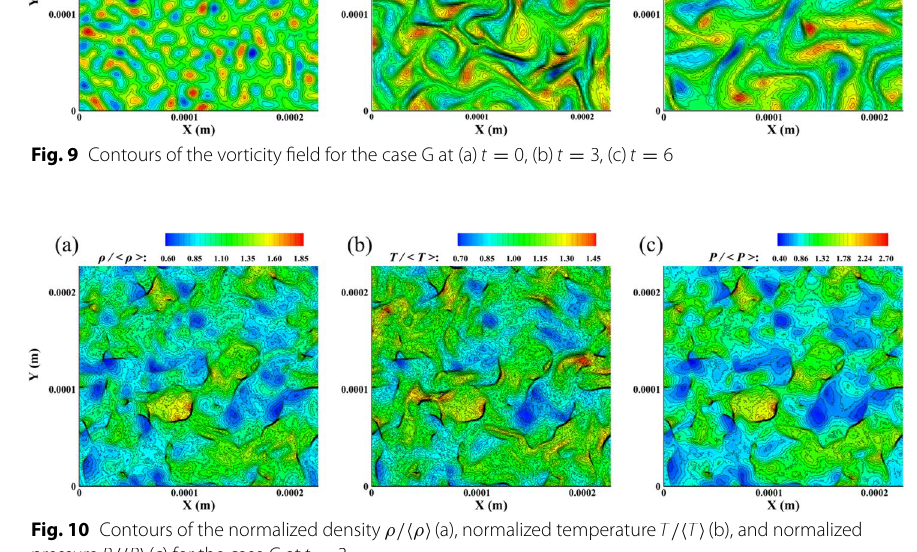
P (c) for the case G at t (cid:31) (cid:30)